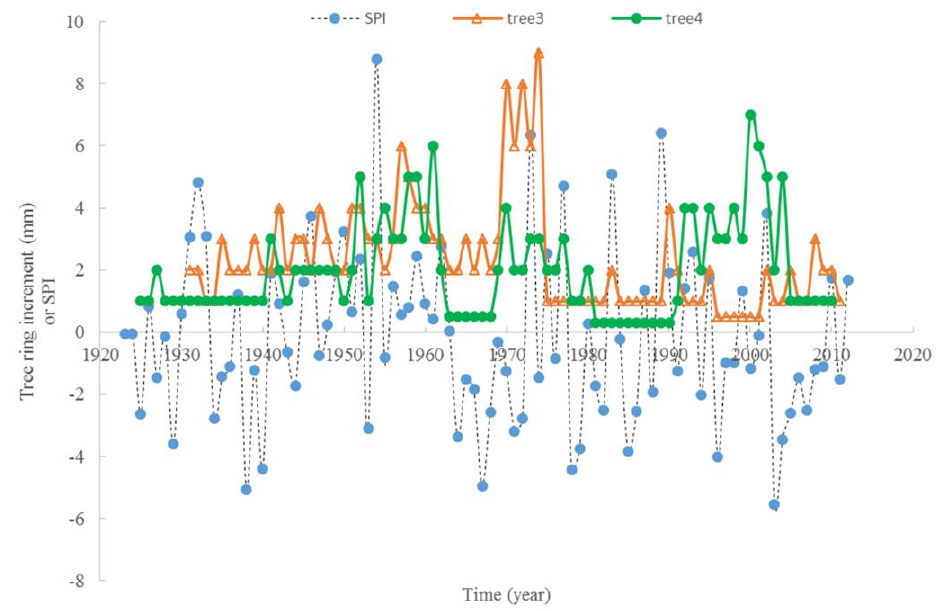
Figure 8. Response of tree ring increment to SPI change with time, for tree #3 and #4 (no negative values for tree ring increment).